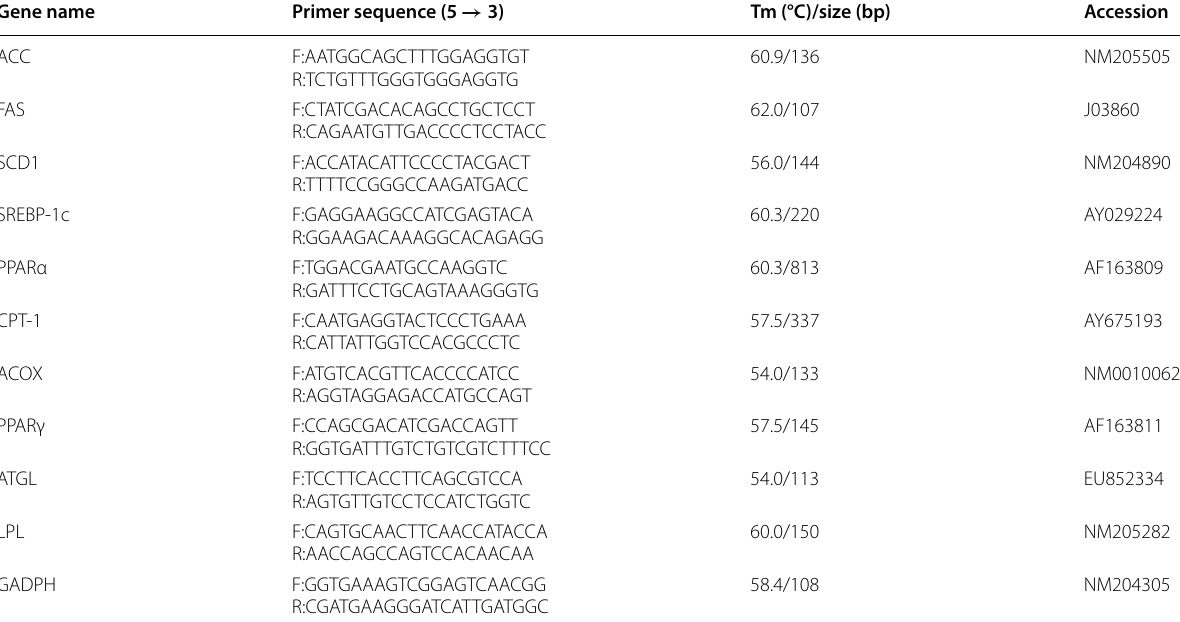
Table 2 Gene-specific primers of the lipid metabolism related enzyme